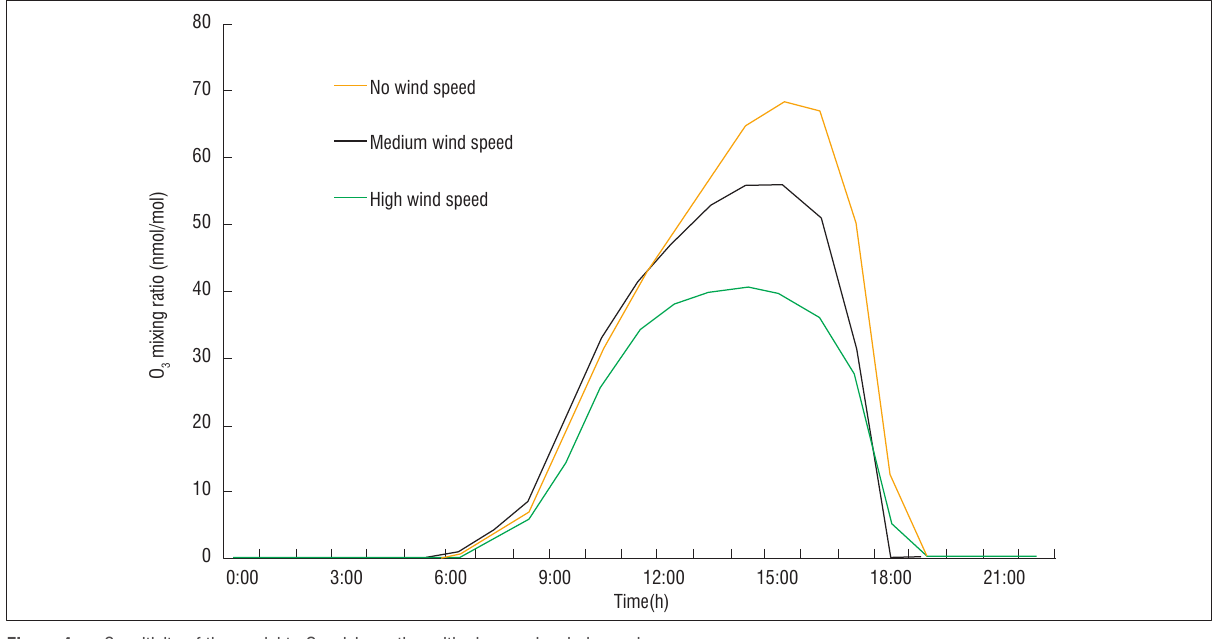
Figure 4: Sensitivity of the model to O